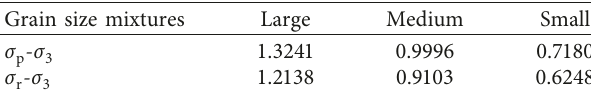
n p - σ 3 and r - σ 3 curves